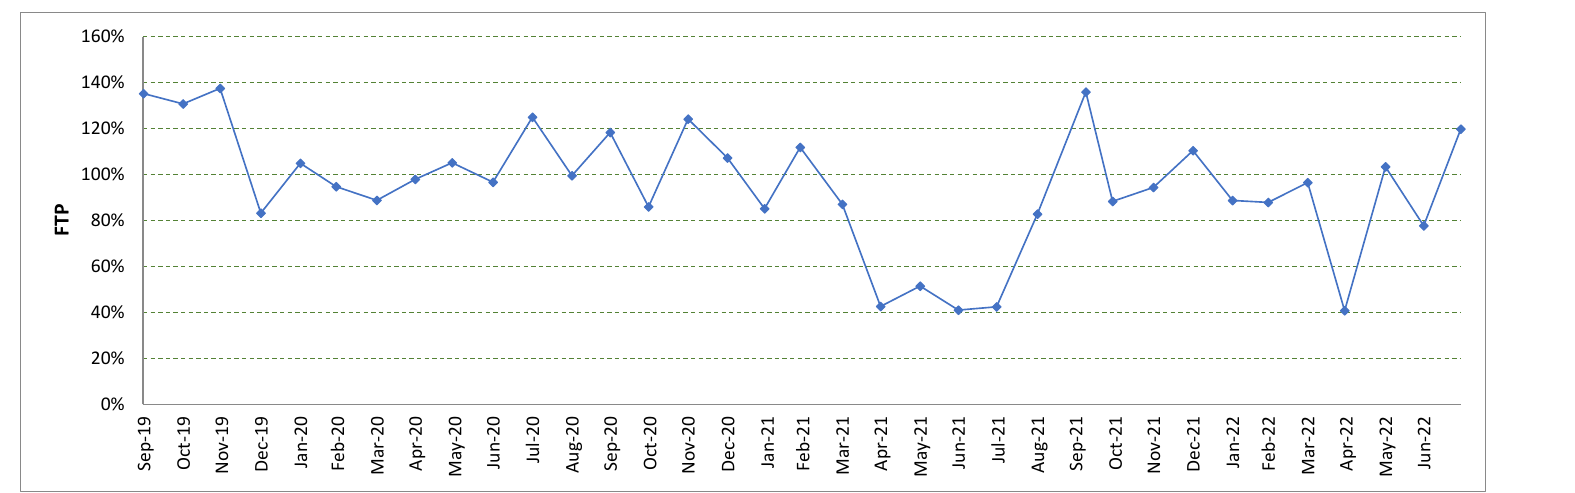
Figure 9. Equally-weighted turbulence-adjusted portfolio.